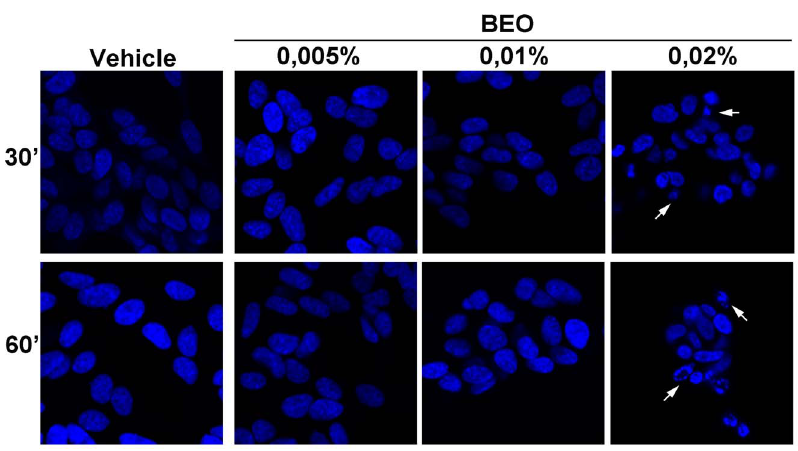
Figure 1. Confocal microscopy of DAPI-stained SH-SY5Y cells treated for up to 1 h with BEO. SH-SY5Y cells were exposed to the indicated concentration of BEO (0.005–0.02%) for 30 or 60 minutes. Apoptotic nuclear morphological changes, such as chromatin condensation and marginalization (arrows), are evident in cells exposed to BEO 0.02%, whereas no nuclear alterations are present in cells exposed to lower concentrations (0.005–0.01%). Images are representative of three independent